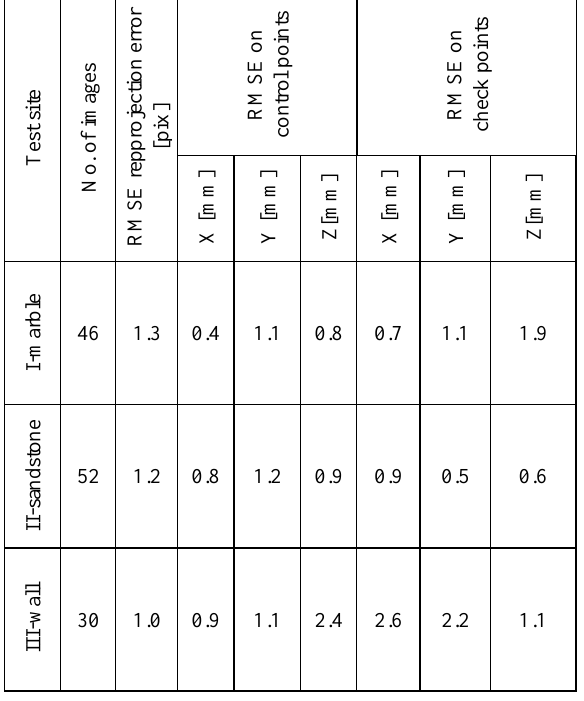
Table 1. The quality assessment of the Structure-from-Motion process